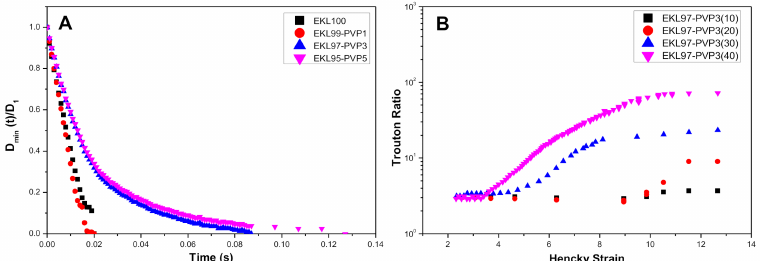
Figure 4. ( A ) Evolution of the normalized filament diameter with time, and ( B ) Trouton ratio versus Hencky strain plot obtained from the transient extensional experiments of EKL/PVP solutions, as a function of EKL:PVP ratio and EKL/PVP concentration,